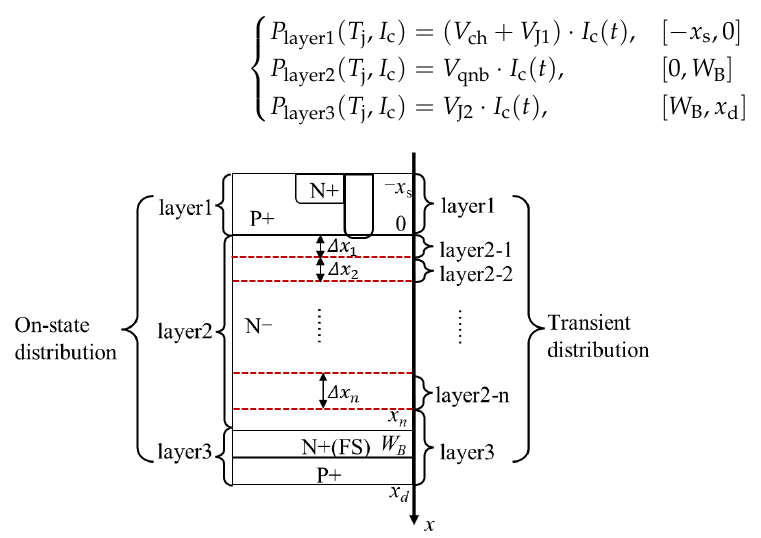
Figure 3. Distributed Heat Source